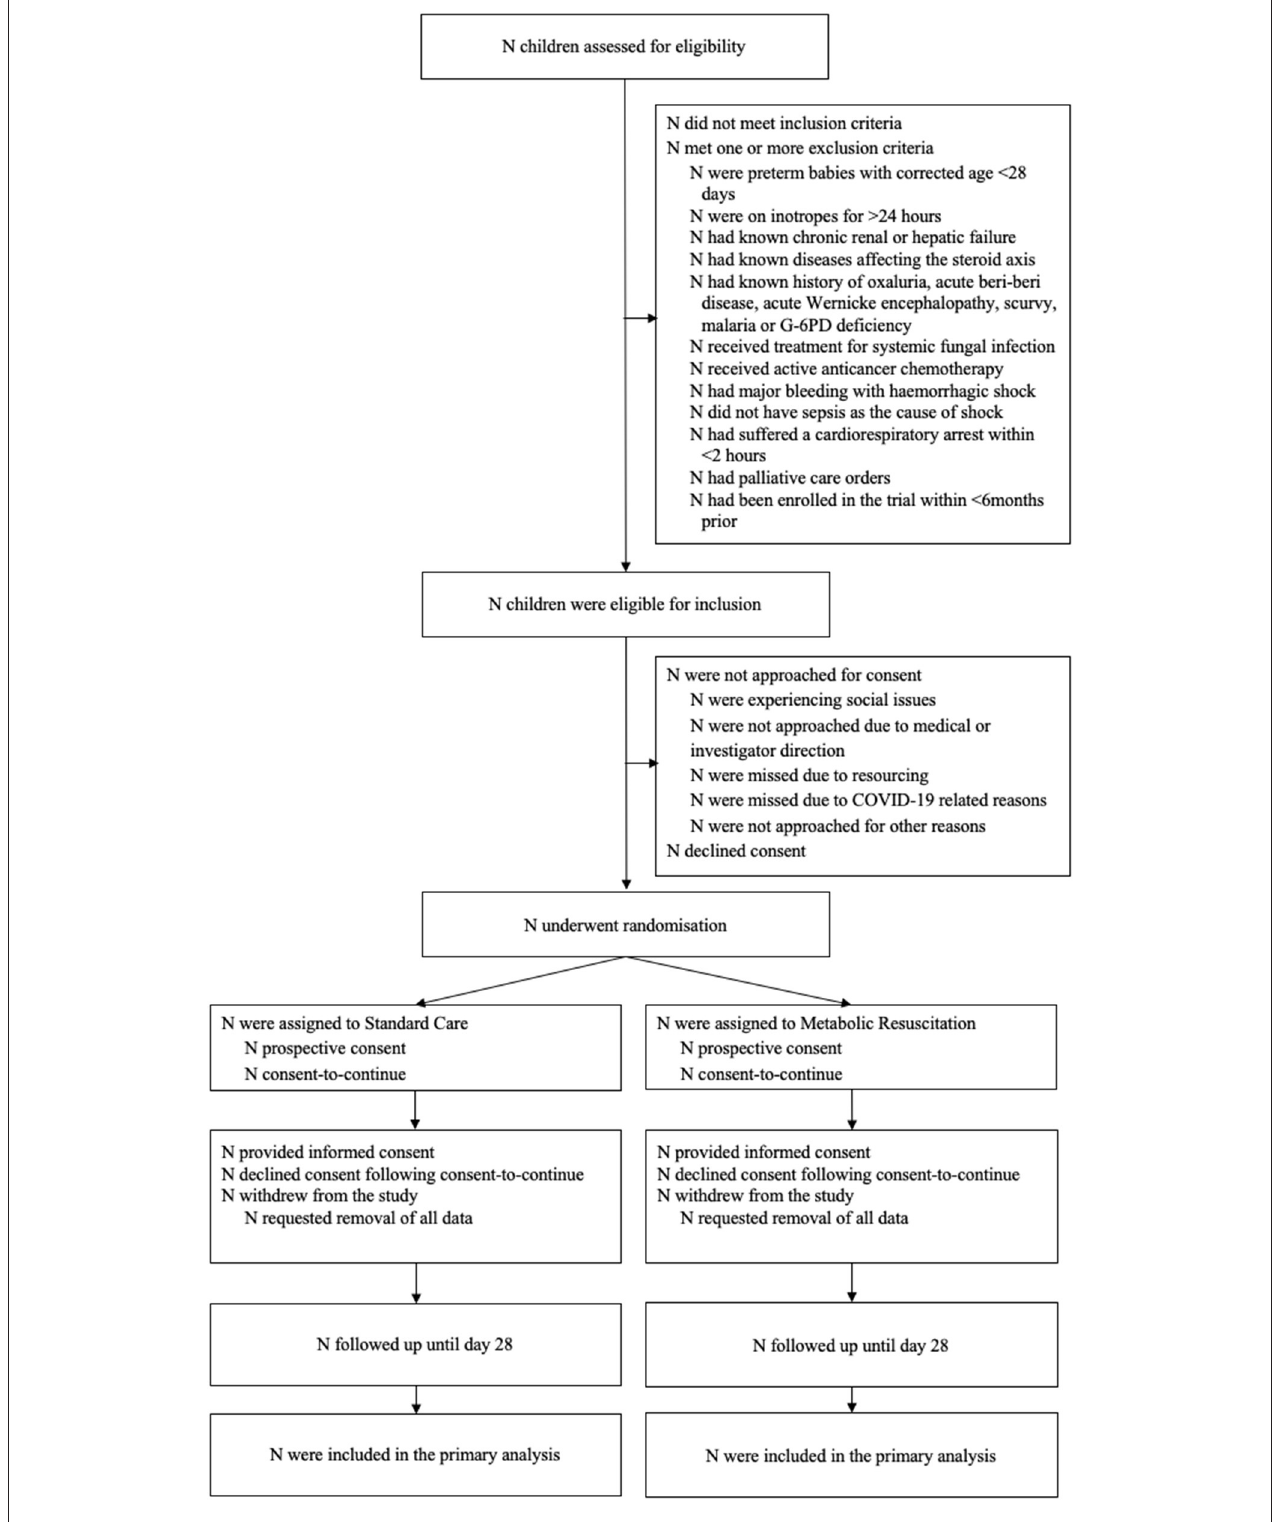
FIGURE 1 | Draft CONSORT participant flow diagram for RESPOND PICU.